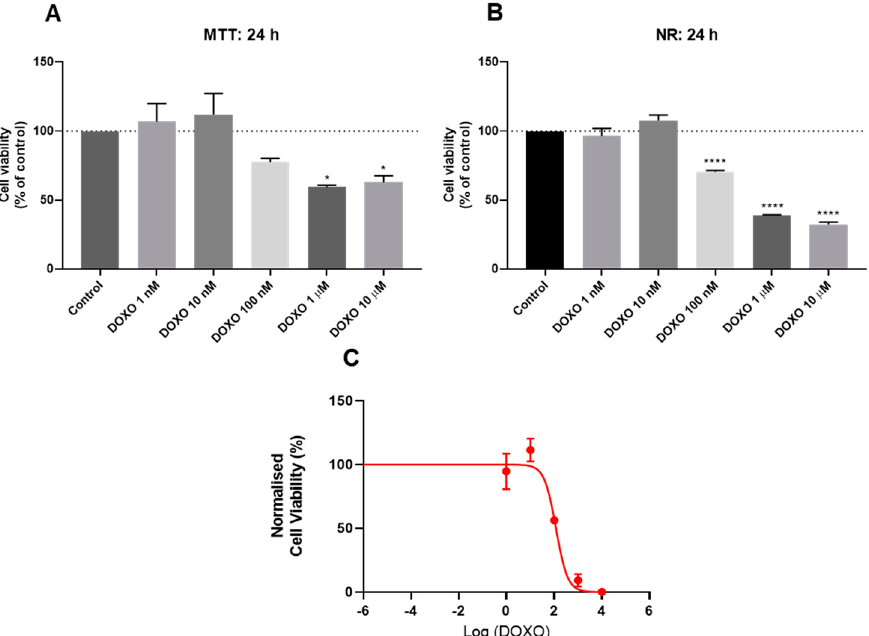
Figure 6. Effects of DOXO on the viability of SH-SY5Y neuroblastoma cells determined by ( A ) MTT and ( B ) NR assays. Based on the results of the NR assay, a dose-response curve was calculated ( C ). Cells were treated with increasing concentrations of DOXO for 24 h. The results are shown as the percentage of the control and are expressed as the mean ± SEM of three independent experiments ( n = 3). * Statistically significant vs. the control at p < 0.05. **** Statistically significant vs. the control at p < 0.0001.